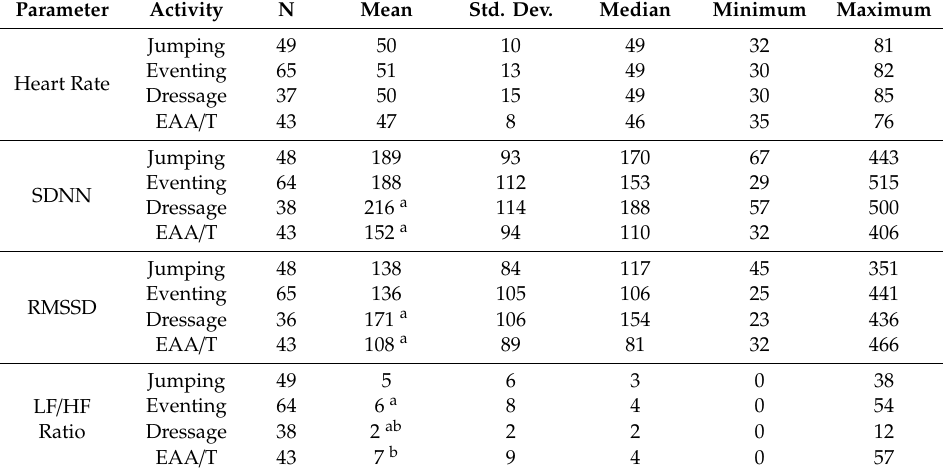
Table 6. Physiological data results of experiment